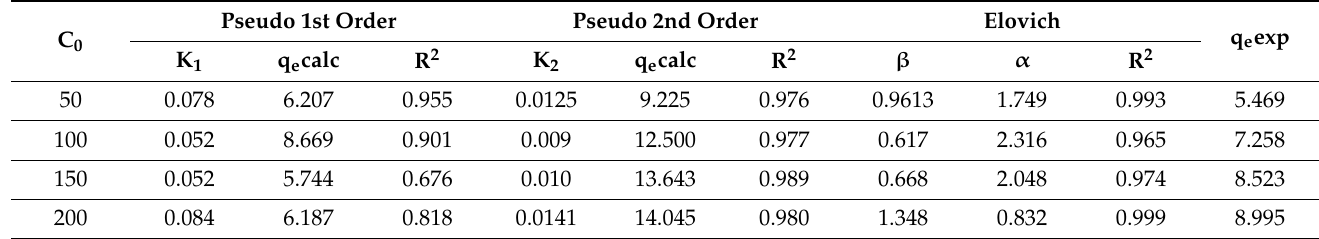
Table 3. Calculated kinetic model parameters for Co adsorption by ZrO 2